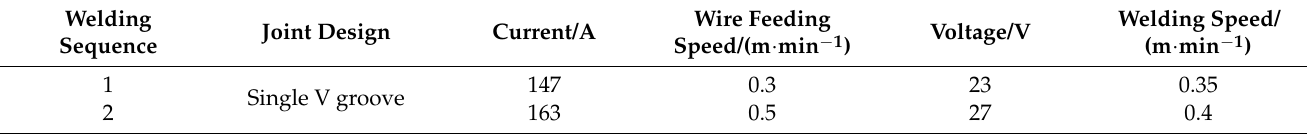
Table 3. Welding